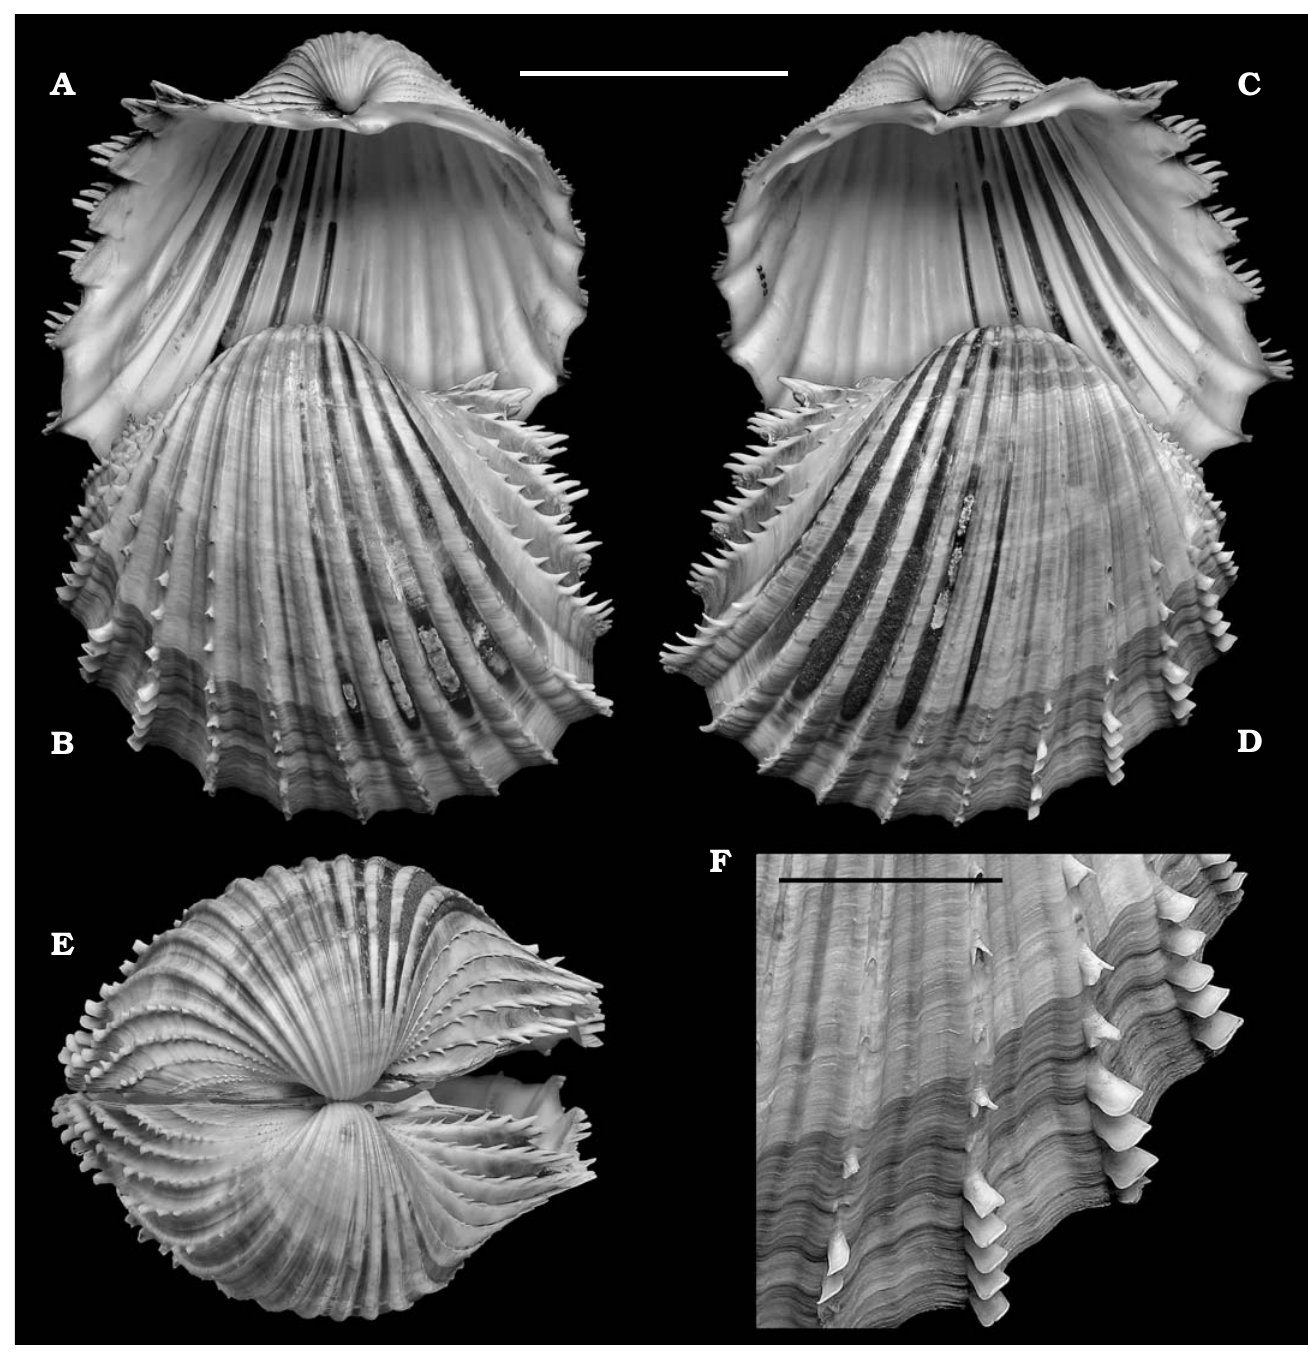
Fig. 1. Cardiid bivalve Procardium indicum (Lamarck, 1819), RMNH.5006725 (ter Poorten collection), Recent, Algeria. Articulated shell in internal ( A , C ), external ( B , D ), and umbonal ( E ) views, with detail of anterior sculpture ( F ). Scale bars: A–E, 50 mm; F, 20